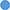
(A) Comparison of the average normalized drop diameter D/Do of drops when the PDMS device is soaked in an oil/water bath (, blue dots), versus drops when the PDMS device is soaked in an oil bath (, red squares). (B) Geometry transformation and volume decrease of drops in the water-soaked PDMS device, imaged by CLSM. Water drops containing ROX fluorescent dye solution is imaged using CLSM and 3D images are used to render models that show shape of the drops at the initial and final time points. Scale bars are 15 μm in CLSM images. Scale bars are 5 μm in the 3D Rendered Model.